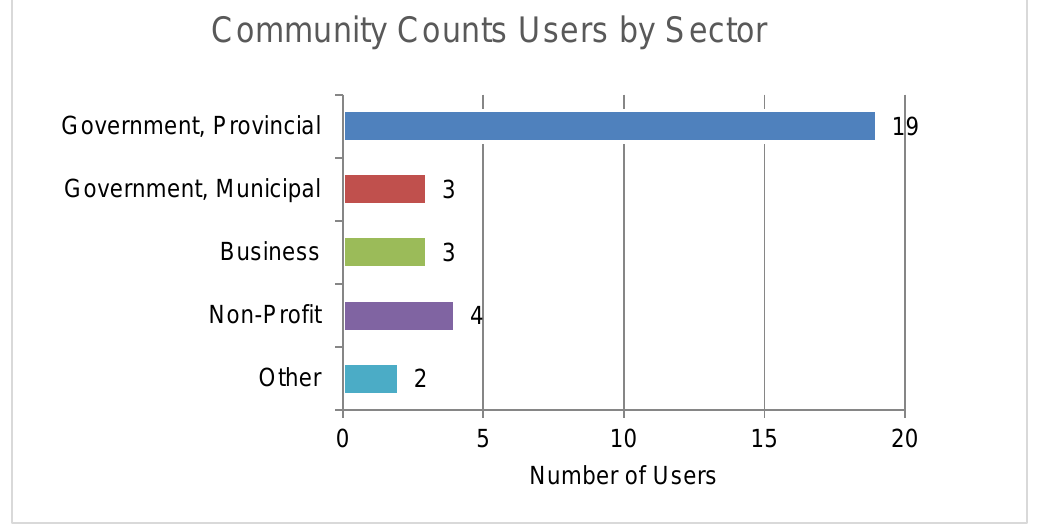
Figure 2: Community Counts Users by Sector, n = 29